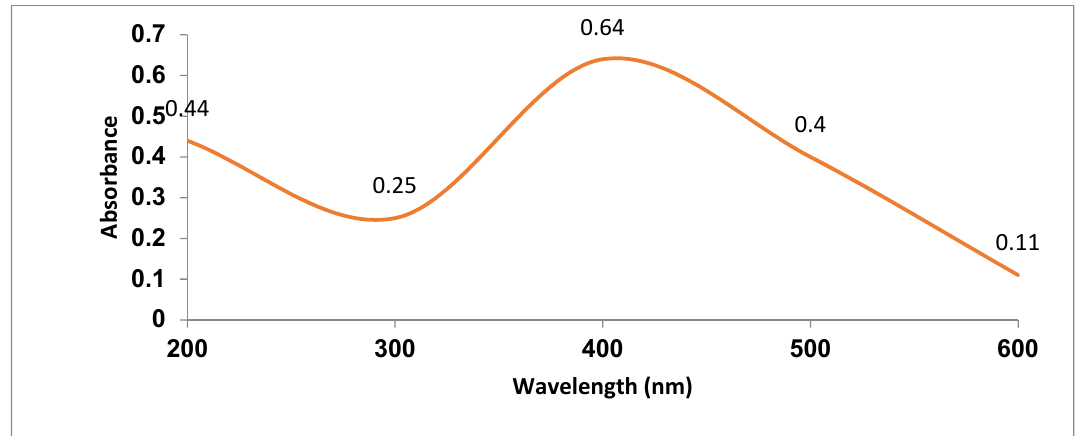
Figure 3. UV-visible absorption spectra of IONPs.